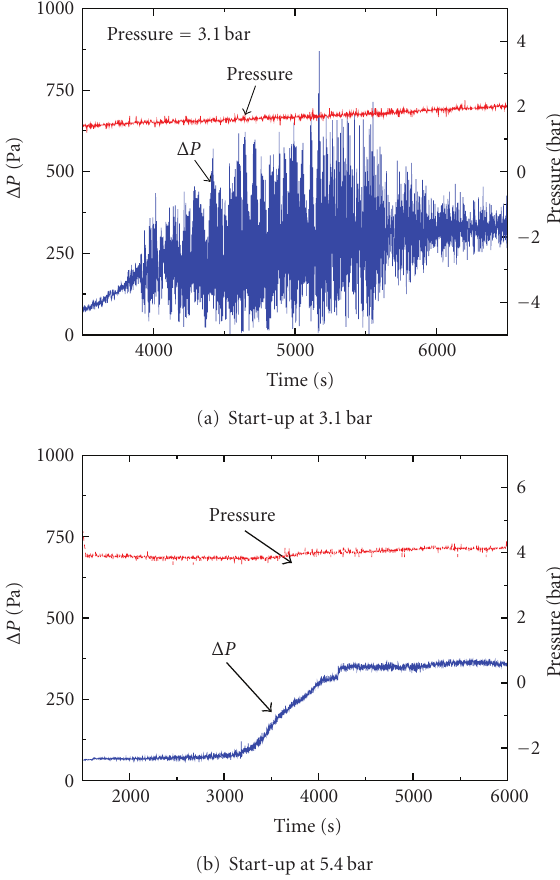
Figure 18: E ff ect of pressure on the instability due to boiling inception in 19.86 mm i.d.